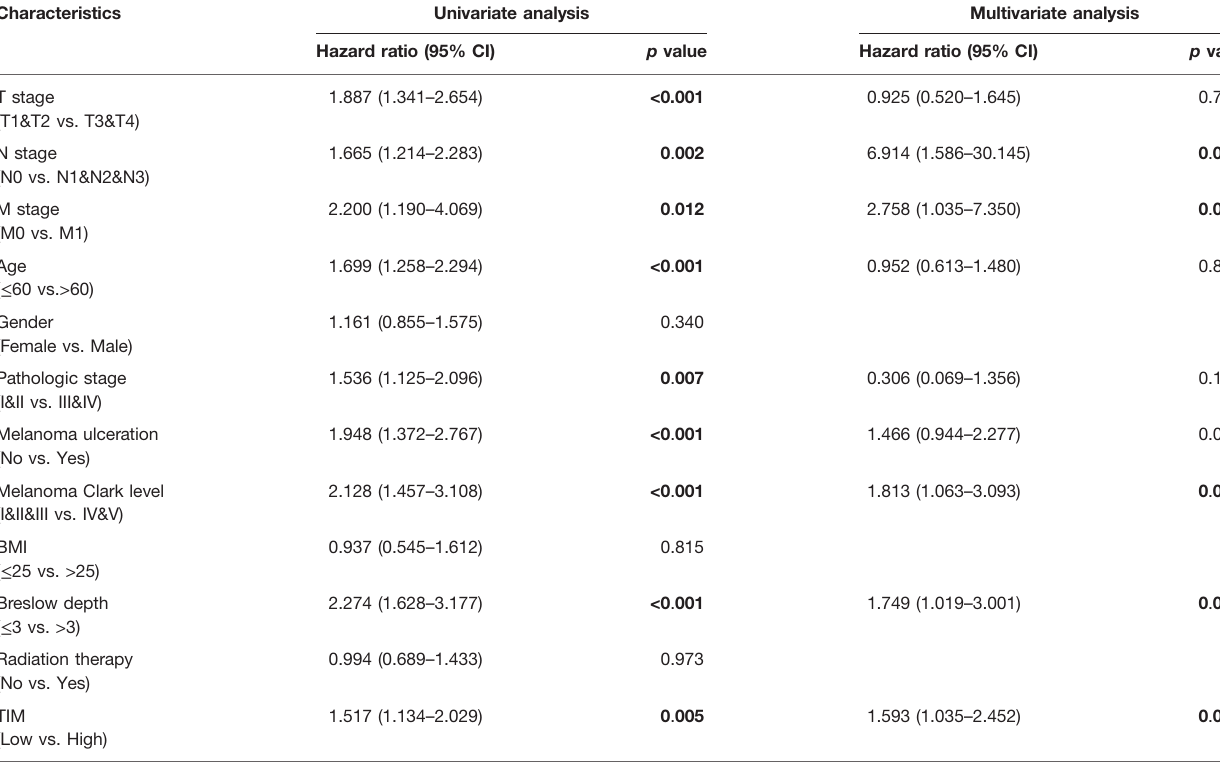
TABLE 4 | Univariate and multivariate Cox proportional hazards analysis of TIM expression and DSS for SKCM patients